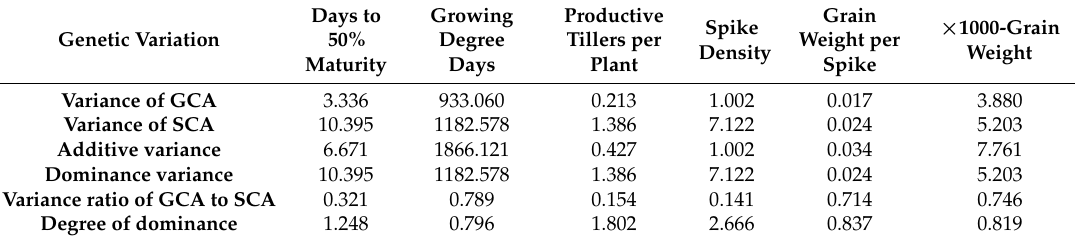
Table 4. Genetic component variations (additive, dominance genetic effects).